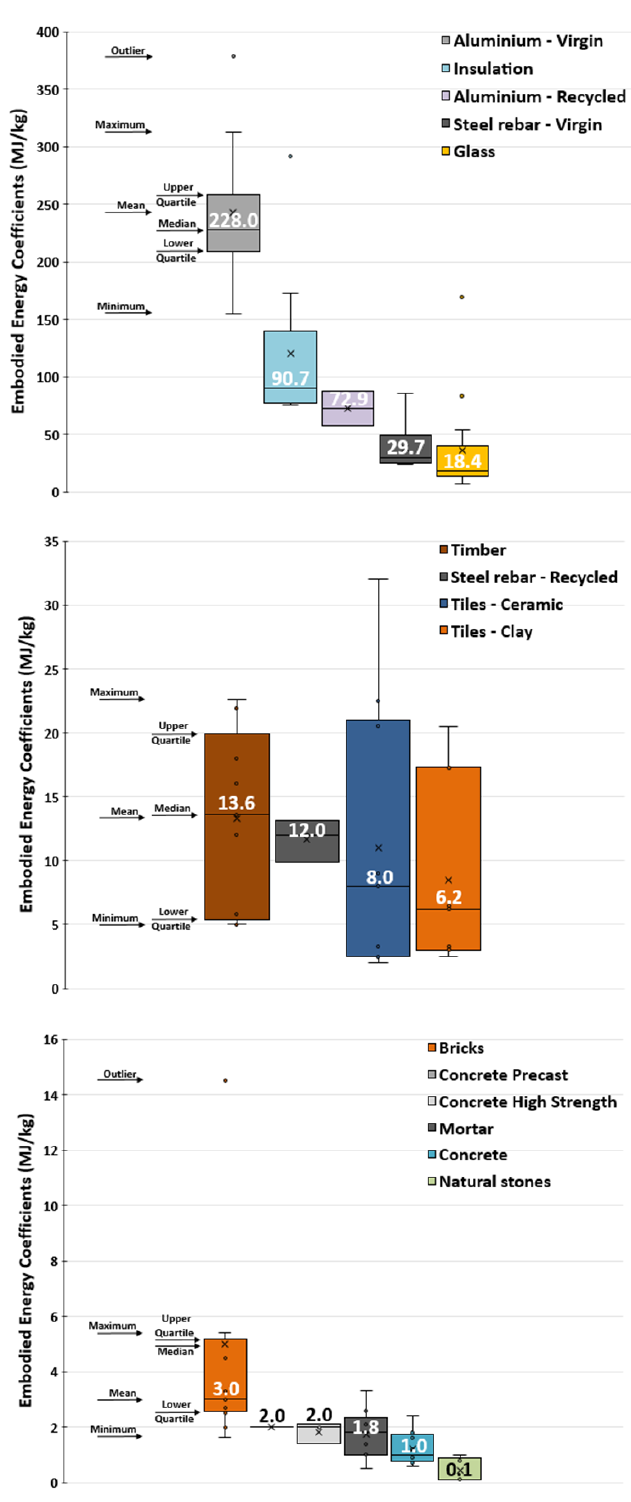
Figure 2. Range and distribution of published values for the embodied energy coefficients (MJ/kg) of commonly used construction materials.